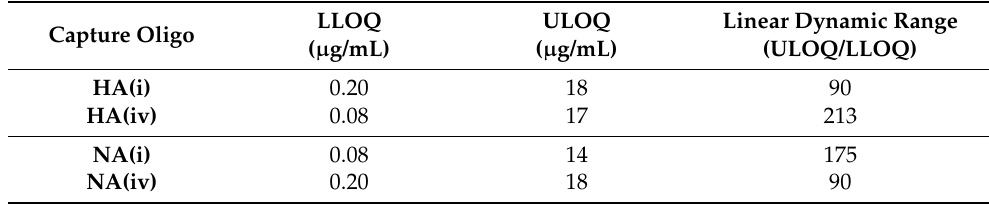
Table 1. Analytical Sensitivity and Range.